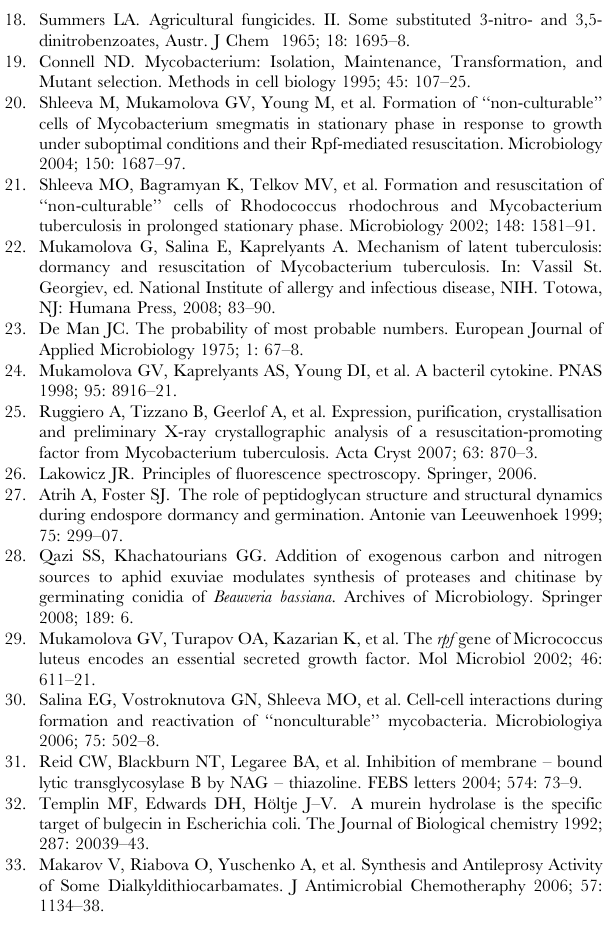
Table S2 Influence of compounds (III) and (VII) on activity of some enzymes t 1/2 - time is needed to achieve a 50% level of substrate conversion. Alcoholdehydrohenase(1.1.1.1) activity : ADH was dissolved in 50 mM phospahe buffer pH 7 at the concentration 10 m g/ml. The rate of the reaction was judged by transformation of NAD + (1 mM) into NADH + H + . As the substrate ethanol was used. Activity was measured by OD 340 . Laccase(1.10.3.2) activity: Laccase was dissolved in the 50 mM citrate-phosphate buffer, pH4.5 at concentration 9 m g/ml. Pyrocatechin was used at concentration 11 m g/ml. Activity was measured by OD 410 . was dissolved in 50 mM Tris-HCl buffer pH 8.0. Concentration